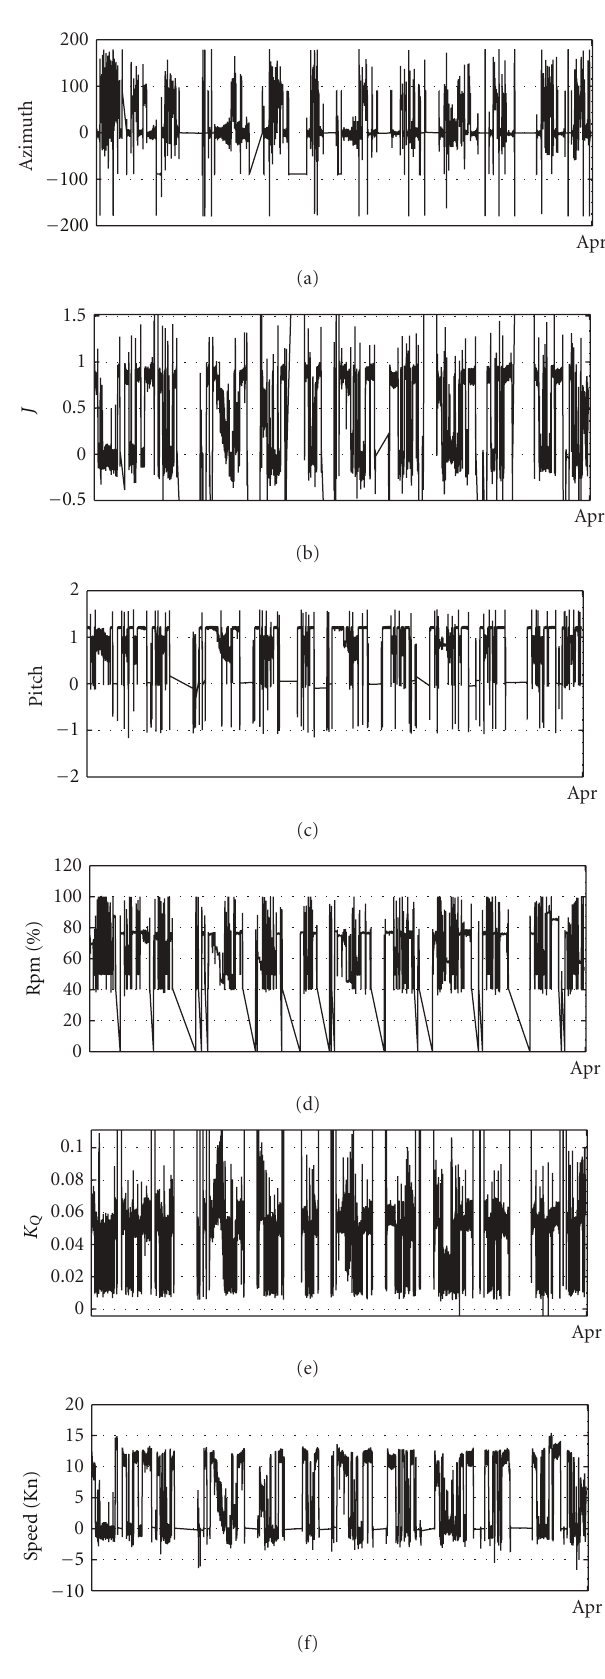
Figure 13: Propulsive parameters during the month of March